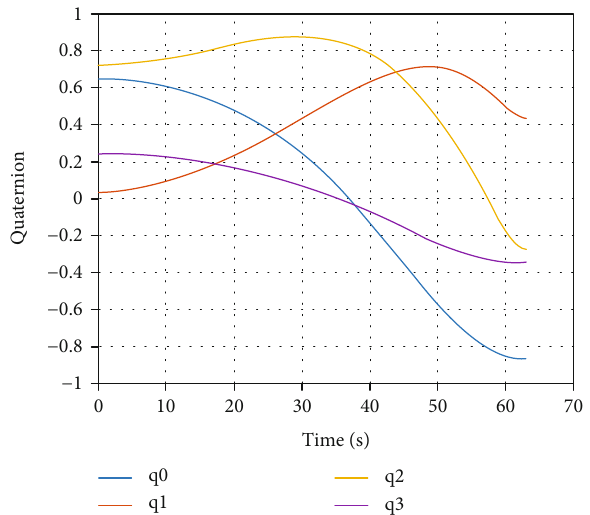
Figure 7: Attitude quaternion time history based on the cross- mutation grey wolf